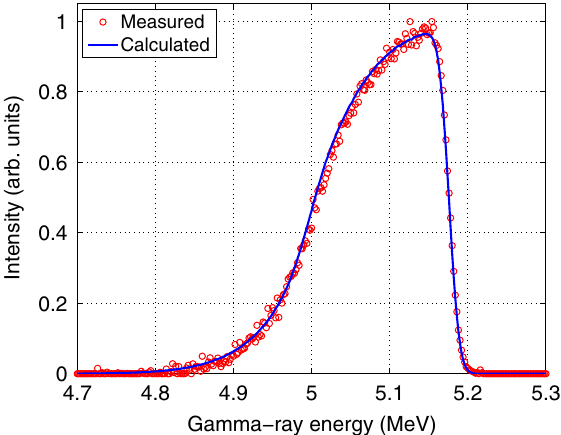
FIG. 11. Comparison between the measured and calculated energy spectra of a Compton gamma-ray beam. The solid line represents the calculated spectrum using the CCSC code, and the circles represent the measured gamma-beam energy distribution after removing the escape peaks and Compton plateau using a spectrum unfolding technique. The gamma-ray beam is pro- duced by Compton scattering of a 466 MeV electron beam and a 790 nm laser beam at the HI (cid:1) S facility. The rms energy spread of the electron beam is 0.1%, and horizontal and vertical emit- tance are 7.8 and 1.0 nm rad, respectively. The collimator with an aperture radius of 12.7 mm is placed 60 meters downstream from the collision